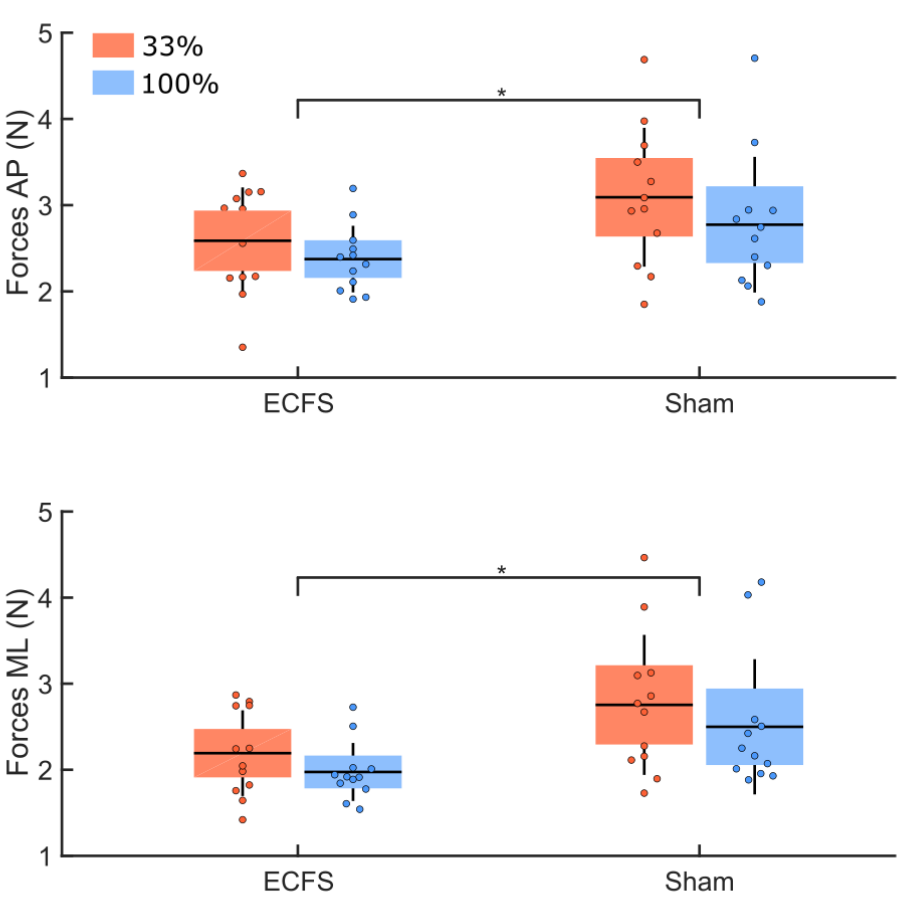
Figure 12. RMS values of the ground reaction forces along the AP (upper panel) and ML (lower panel) axes for both groups (33% and 100%, red and blue respectively). These data are for the control condition (ECFS) and the sham condition. The dots represent the mean results for each participant, horizontal lines depict the group’s means, boxes represent the group’s standard error of the mean, and vertical lines, one standard deviation. The asterisks (*) indicate a significant main effect of condition.